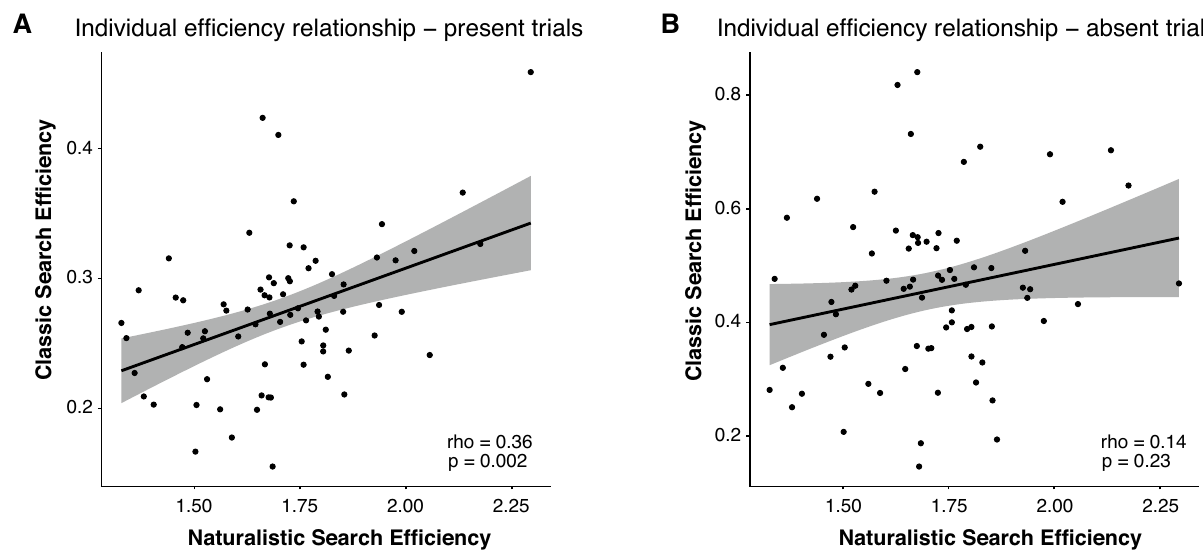
Figure 4. Relating individual performance across tasks. An individual’s efficiency in the classic visual search task relates to efficiency in the naturalistic visual search task for ( A ) target present trials ( r s = 0.36, p = 0.002) but not for ( B ) target absent trials ( r s = 0.14, p =